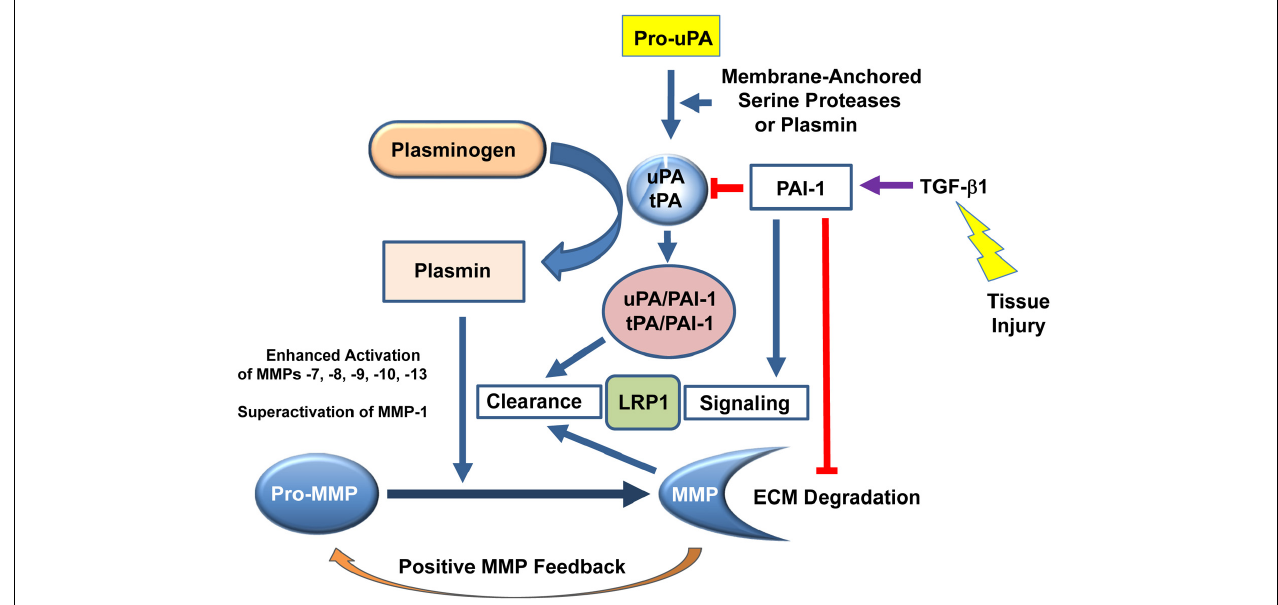
FIGURE 3 | PAI-1 (SERPINE1) is a critical factor in the regulation of the pericellular proteolytic microenvironment and fibrotic response to tissue injury. Plasminogen activators (urokinase, uPA; tissue-type, tPA) are the physiologically and pathophysiologically-relevant plasmin-generating proteinases that impact extracellular matrix (ECM) accumulation/degradation through a complex and highly interdependent proteolytic cascade. Pro-uPA is cleaved to the active enzyme uPA by membrane-anchored serine proteases (e.g., Matriptase, Hepsin, Serase-1B) or catalytically-active levels of plasmin. uPA-induced conversion of plasminogen to plasmin results in the significant downstream mobilization of several matrix metalloproteinases (MMPs). Collectively, both the plasmin-dependent and MMP proteolytic systems dictate the extent and locale of ECM remodeling. Elevated expression or bioactivity of PAI-1, generally in response to tissue injury-induced TGF- β 1, facilitates ECM accumulation and inhibits ECM degradation which, if prolonged or chronic, leads to the initiation and progression of fibrotic